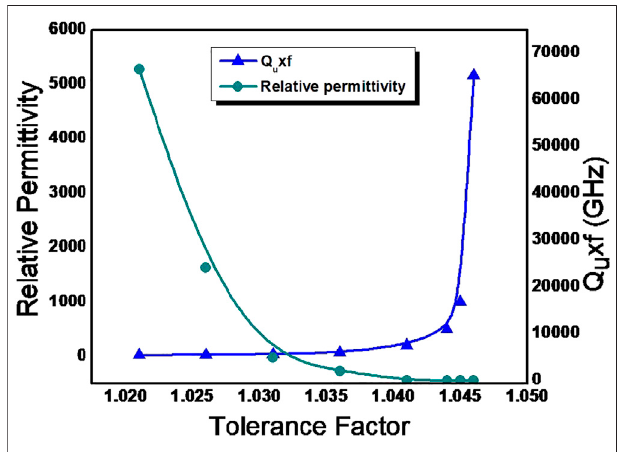
FIGURE 6 | Variation of Relative permittivity and Quality factor with tolerance factor of BaZr 0.2 [Ti (1-x) Mg x/3 Ta 2x/3 ] 0.8 O 3 solid solution